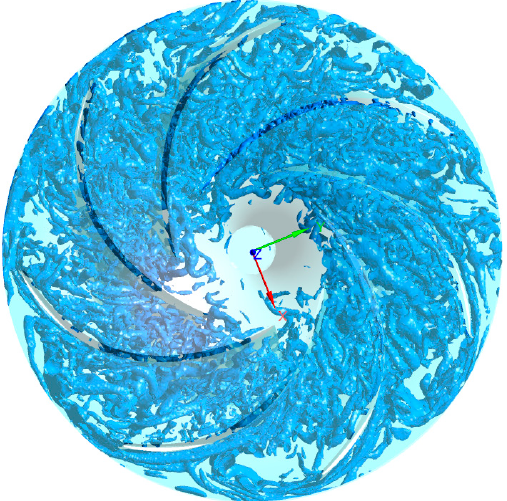
Figure 8. Vortex structures at 1%Pn (10% characteristic scale).